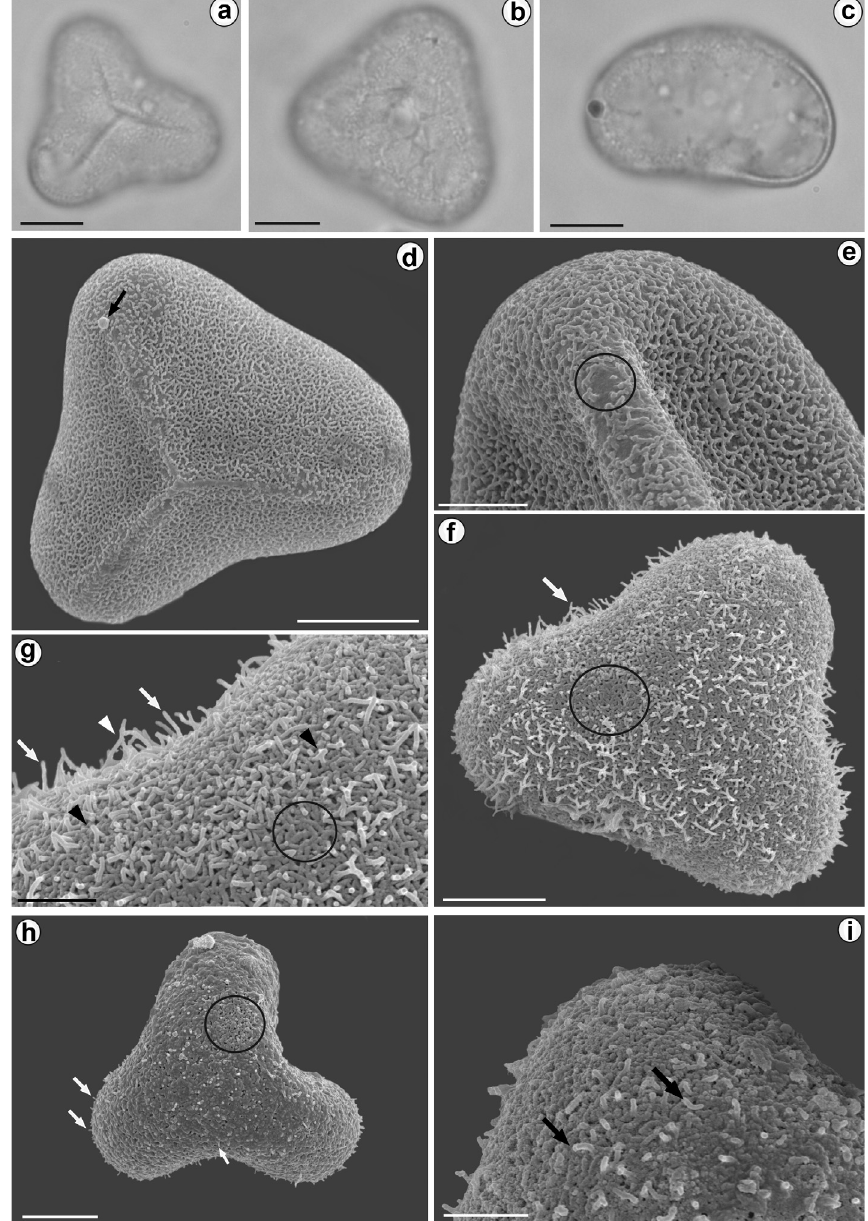
Figure 1 - Spores of Microlepia speluncae with LM ( a-c ) and SEM ( d-i ). a. Spore in proximal view. Scale bar = 10 μ m. b. Spore in distal view. Scale bar = 10 μ m. c. Spore in equatorial view. Scale bar = 10 μ m. d. Spore in proximal view. The spore surface bears a three-dimensional network of branching threads. Spheroids are observed (arrow) Scale bar = 10 μ m. e. Detail of the proximal view. The laesurae are partially covered of threads. An irregular surface below the threads network is observed (circle). Scale bar = 6 μ m. f. Spore in distal view. The ornamentation is formed of a three-dimensional network of fused and rami fi ed thread (circle). Some threads, oriented perpendicular to the surface are evident, which are higher on the spore sides (arrows). Scale bar = 10 μ m. g. Detail of the distal surface, formed of threads tangentially (circle) and perpendicular (arrow) oriented. Some of the last ones are fused at the top to form spinules (arrowhead). Scale bar = 6 μ m. h. Spore in distal view. A granular layer covers the threads background, and only the perpendicular threads can be observed (arrow). Threads tangentially oriented to the spore surface are only visible where the granular layer is not present (circle). i. Detail of the distal surface. The tips of the threads tangentially oriented are evident (arrow). Scale bar = 5 μ